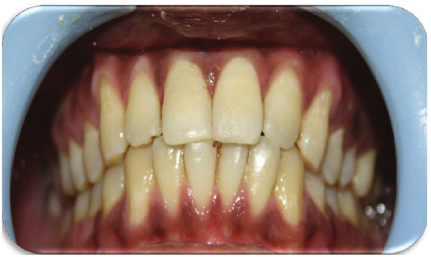
Figure 8: Postoperative